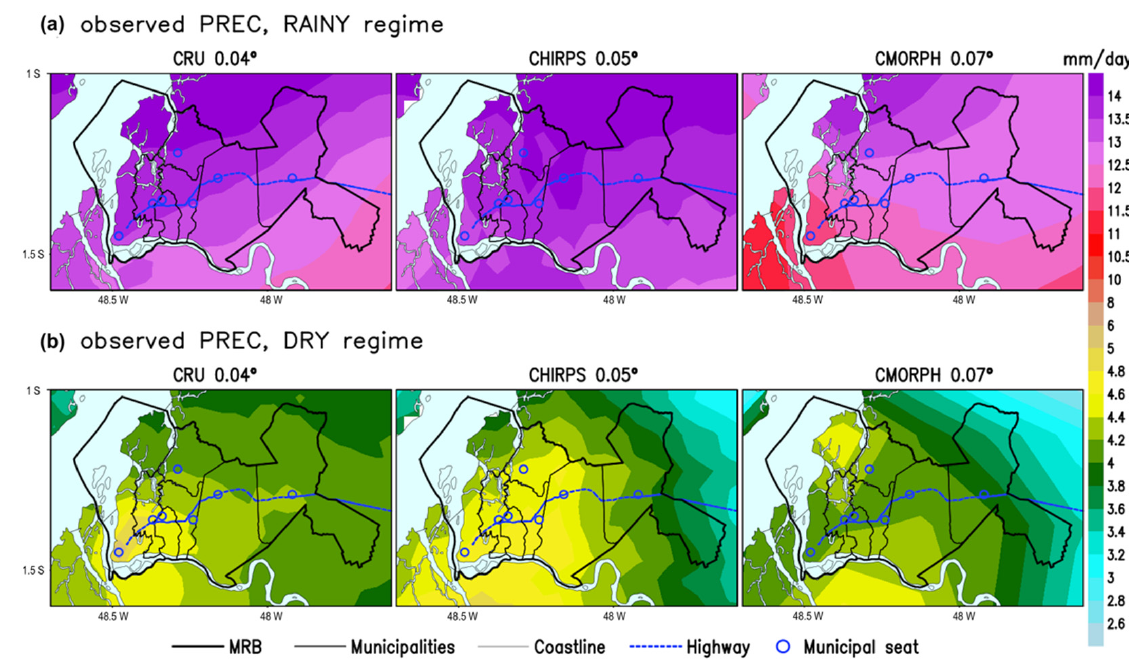
Figure 4. CRU, CHIRPS, and CMORPH observed PREC (mm/day) for ( a ) RAINY; ( b ) DRY regime.